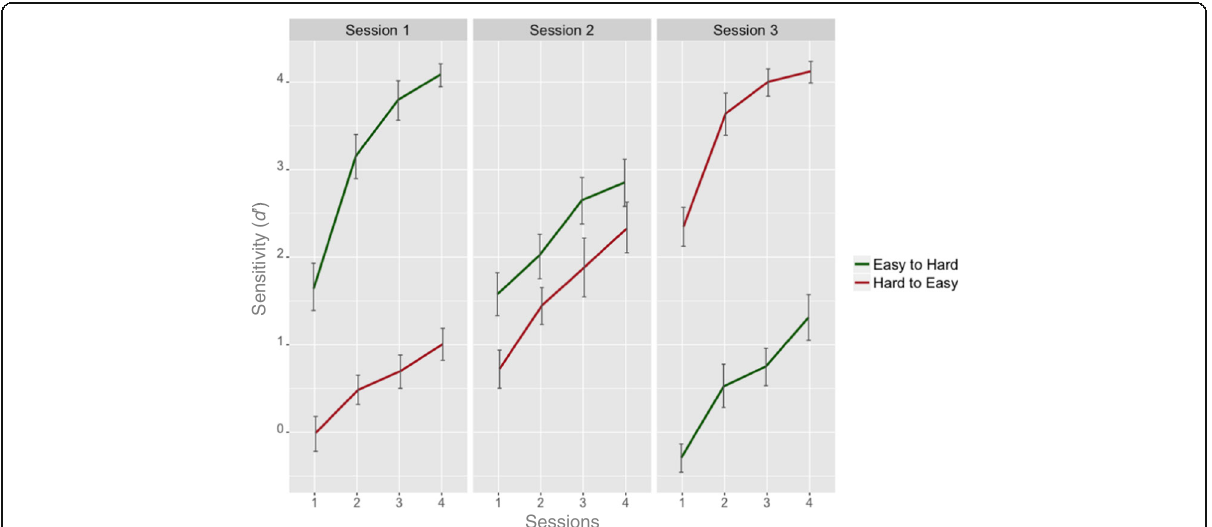
Fig. 5 The performance (as measured by d ’ ) throughout the training for the easy-to-hard and hard-to-easy training group. Error bars denote 95% confidence intervals